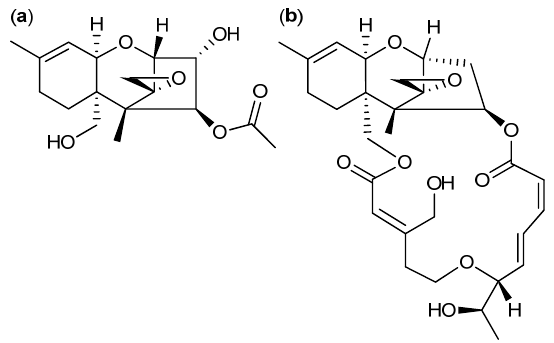
Figure 19. Trichothecenes ( a ) AETD and ( b ) 12 ′ -Hydroxyroridin